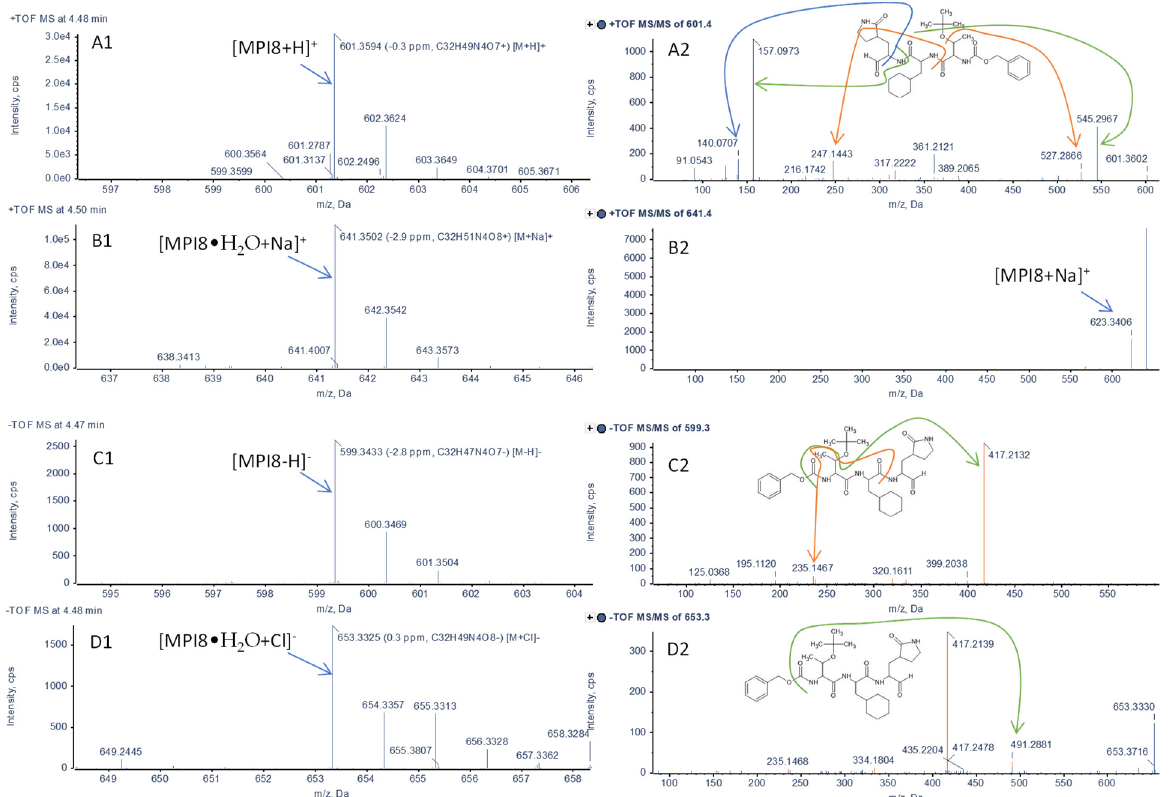
Figure 3. HR MS and MS/MS spectra of MPI8 and MPI8 • H 2 O using an extracted sample from MPI8 spiked plasma at retention time of 4.5 min after column elution on an X500B QTOF mass spectrometer; ( A1 , A2 ) and ( B1 , B2 ) in positive mode, ( C1 , C2 ) and ( D1 , D2 ) in negative mode; the proposed fragmentation of product ions are shown on MS/MS spectra: ( A1 ) protonated MPI8 [MPI8 + H] + MS ( m / z 601.3594), ( A2 ) protonated MPI8 [MPI8 + H] + MS/MS; ( B1 ) [MPI8 • H 2 O + Na] + MS ( m / z 641.3502) ( B2 ) [MPI8 • H 2 O + Na] + MS/MS; ( C1 ) deprotonated MPI8 [MPI8 − H] − MS ( m / z 599.3433), ( C2 ) deprotonated MPI8 [MPI8 − H] − MS/MS; ( D1 ) [MPI8 • H 2 O + Cl] − MS ( m / z 653.3325), ( D2 ) [MPI8 • H 2 O + Cl] − MS/MS.